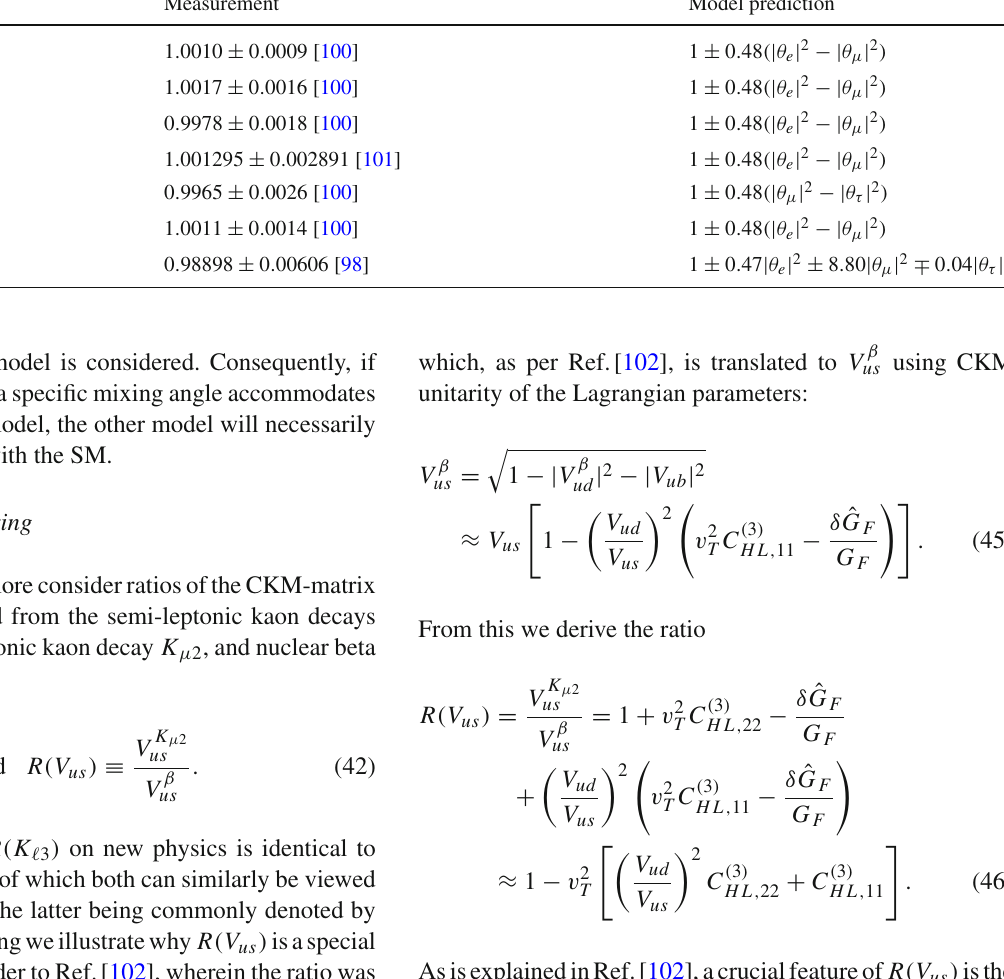
to a less competitive bound [98]. The model predictions are obtained from matching onto SMEFT at the Seesaw scale μ = M X = 1TeV and running to the electroweak scale μ = m Z . In the right column, the upper sign refers to Type-I Seesaw, whereas the lower sign stands for Type-III Seesaw